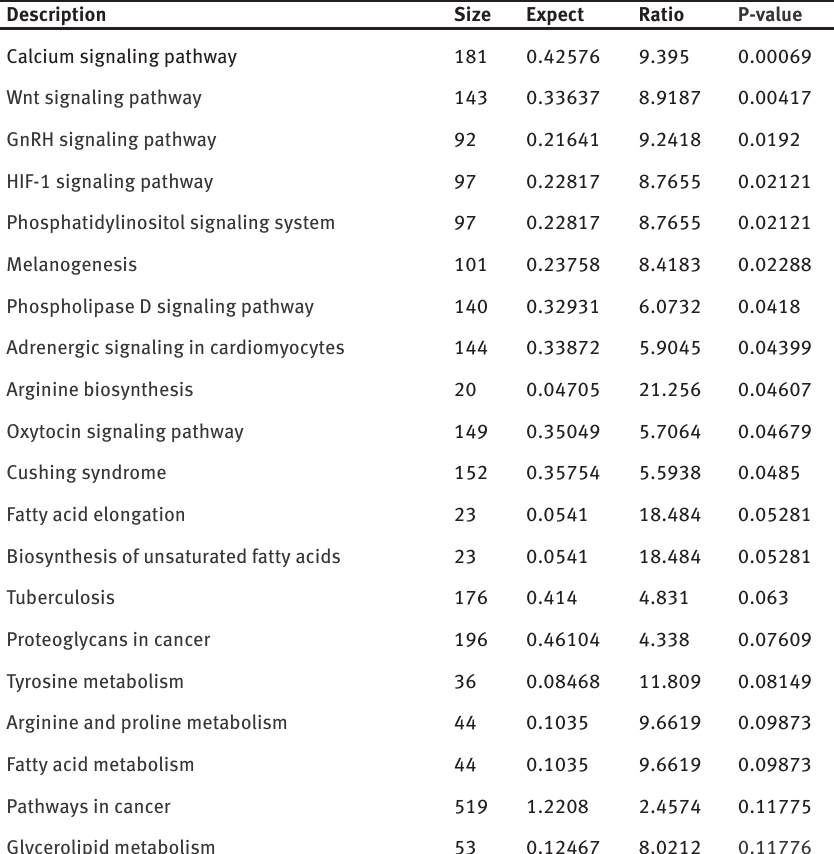
Table 4: KEGG pathway enrichment for iNOS/NOS2 and co-expressed